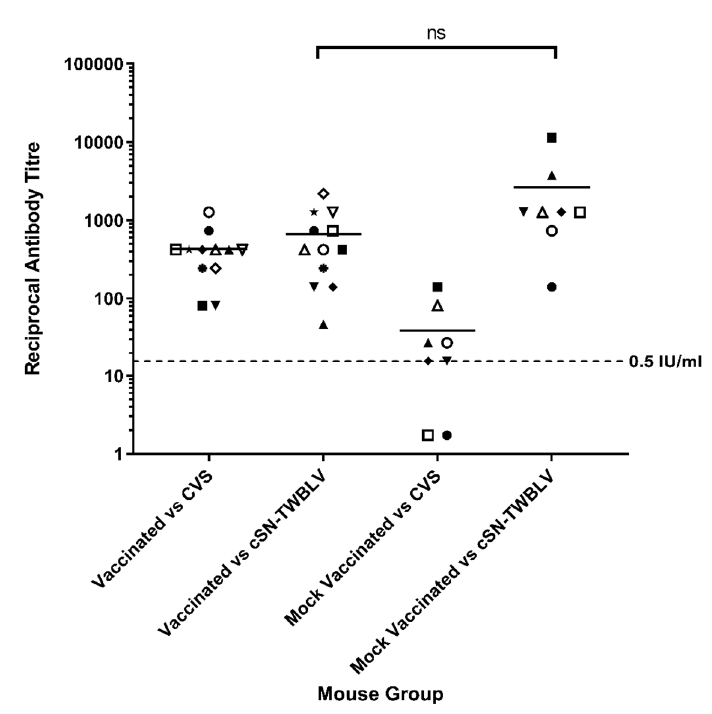
Figure 6. Serological evaluation of sera taken at termination cSN-TWBLV challenged mice were serologically assessed against CVS and cSN-TWBLV using FAVN and modified FAVN assays. The dotted line represents the 0.5 IU/mL antibody neutralization cut-off dictated by WOAH sera against CVS. Each symbol is representative of one animal. Scale is logarithmic. Significant differences between the groups were calculated using the Kruskal-Wallis test with Dunn’s multiple comparisons test (ns is not significant).